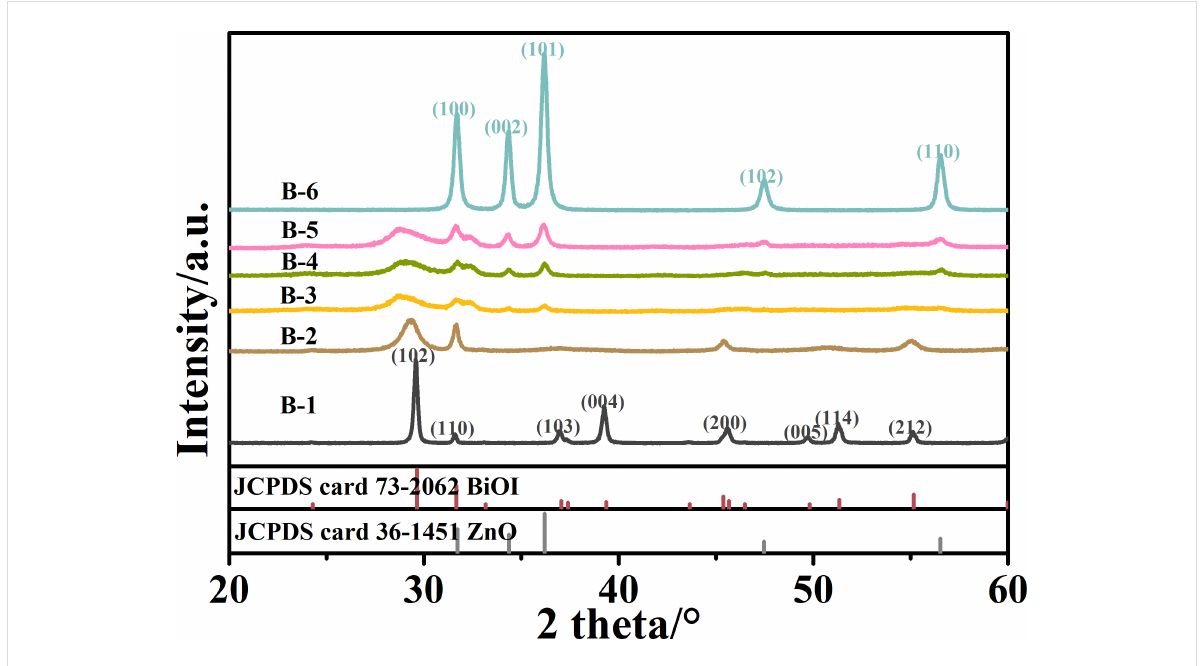
Figure 1: The X-ray diffraction patterns of all of the as-synthesized samples with different Bi/Zn molar ratios (with reference ZnO and BiOI XRD patterns as comparison). All peaks are in good agreement with the tetragonal BiOI and/or the hexagonal ZnO phases.